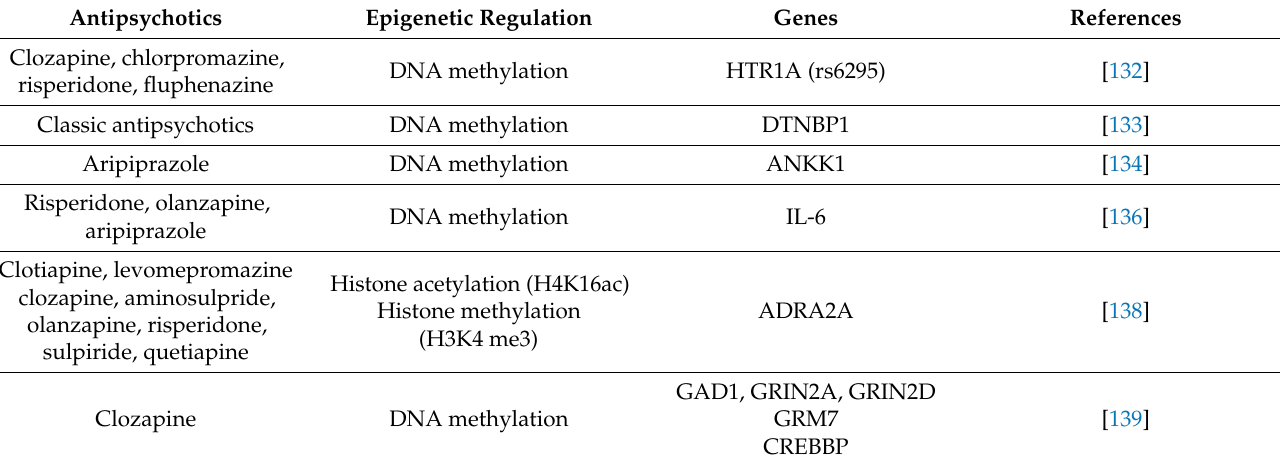
Table 3. Effects of antipsychotics on epigenetic regulation of gene expression in patients with